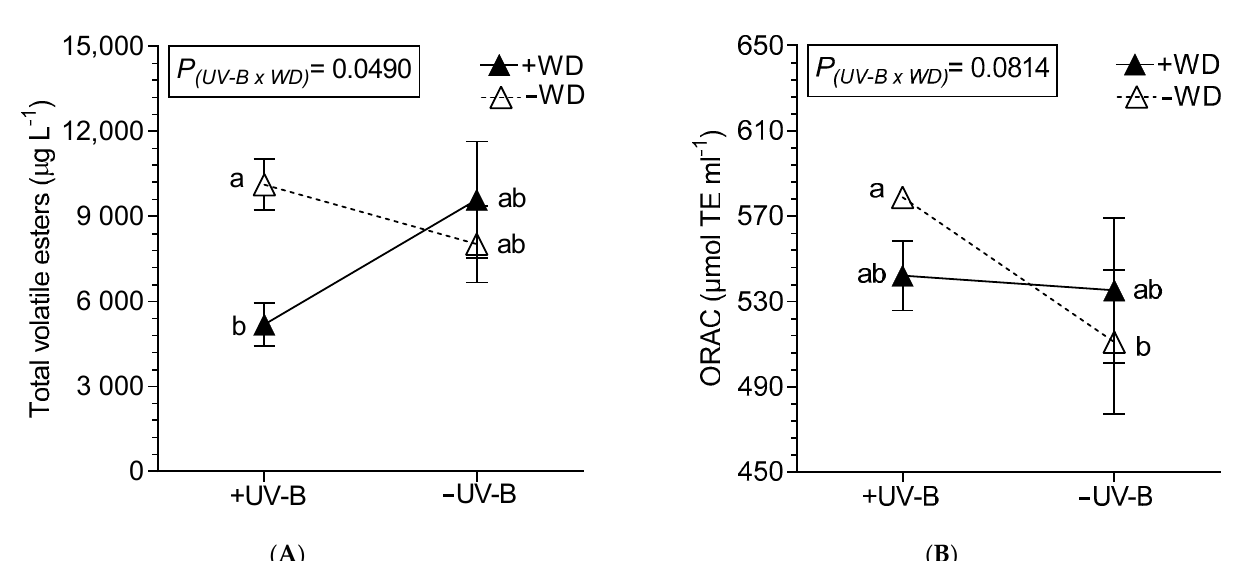
Figure 5. Interaction between UV-B and WD for total volatile esters ( A ) and ORAC ( B ), determined in wines from Malbec plants exposed to combined UV-B, WD and ABA treatments. Values are means for each factor combination ±SEM (n = 3) and different letters indicate significant differences (Fisher’s LSD, p ≤ 0.05).